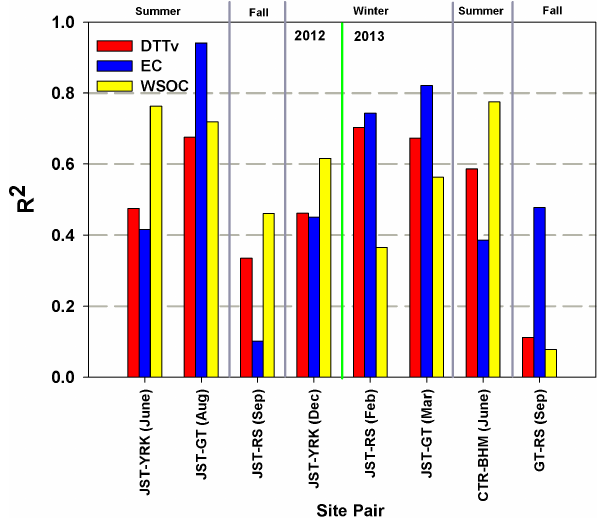
Figure 5. Site-to-site correlations ( R 2 ) for volume normalized DTT activity (DTTv), EC and WSOC of PM 2 . 5